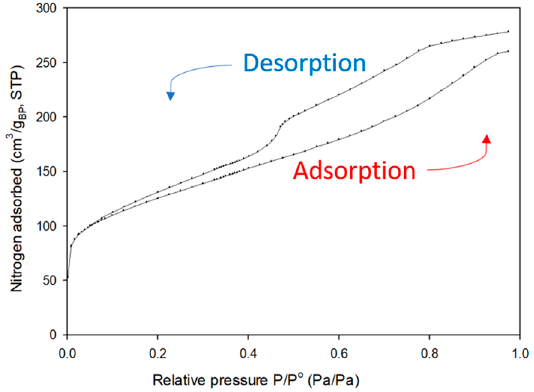
Figure 7. Isotherm graph for the adsorption (lower line) and desorption (higher line) of nitrogen in the BP.